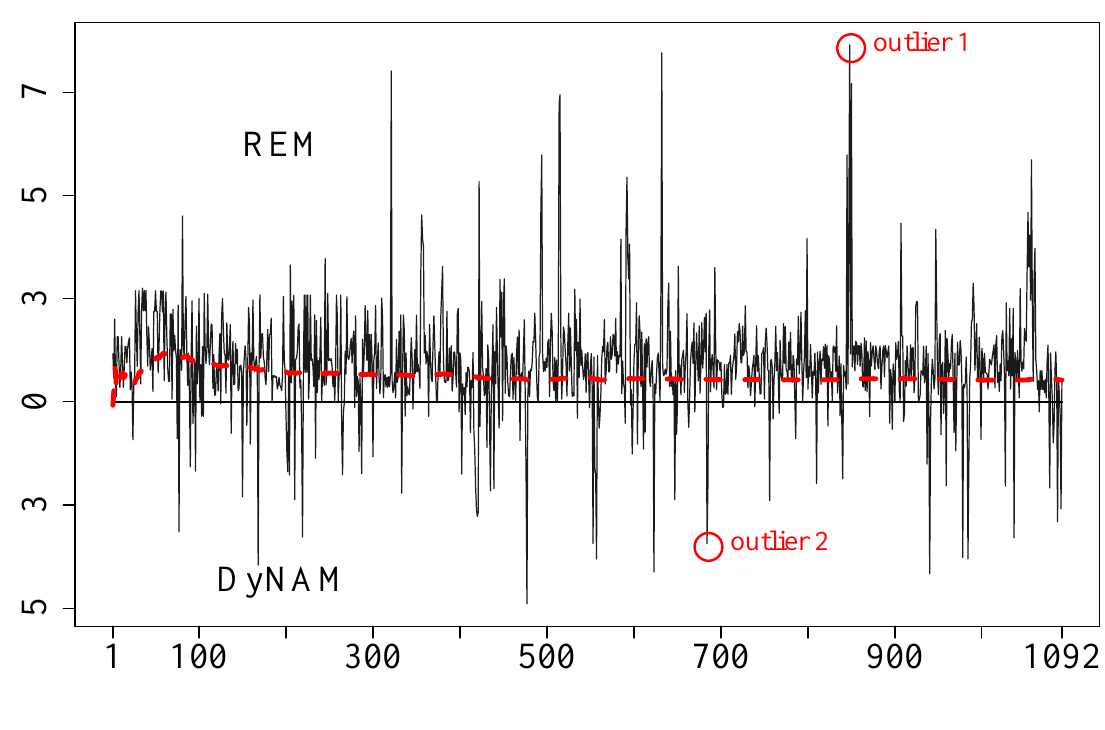
Figure 5: Likelihood ratios (logged for better readability) per event in an ordered model that ignores right- censored intervals and just models sequences. Events above the 0 line favor the REM, events below favor the DyNAM. Two outliers are exemplarily discussed in the text. The dashed line shows for each event the average likelihood ratios of all prior